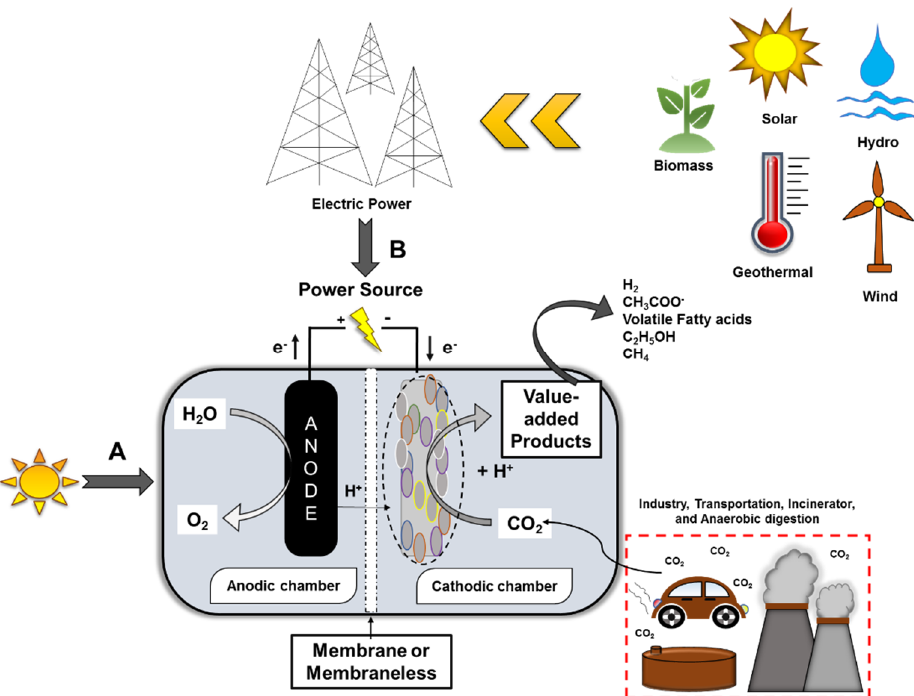
Figure 5. Microbial Electrosynthesis power supply with ( A ) Direct and ( B ) Indirect source. Production of high value-added chemicals and corresponding extracellular electron transfer (EET) processes interpreting the flow of electrons from the cathodic electrode to CO 2 , the terminal electron acceptor